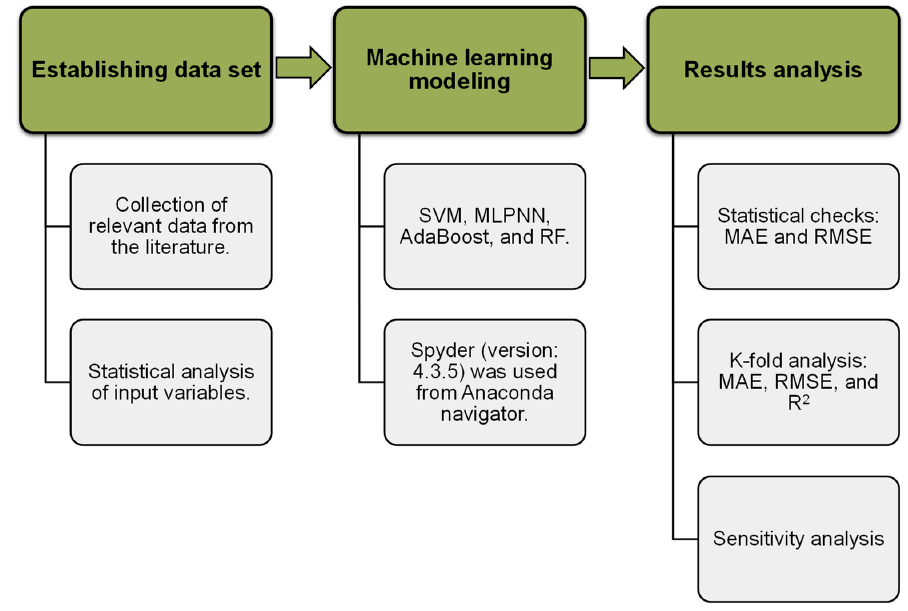
Figure 2. Sequence employed for the